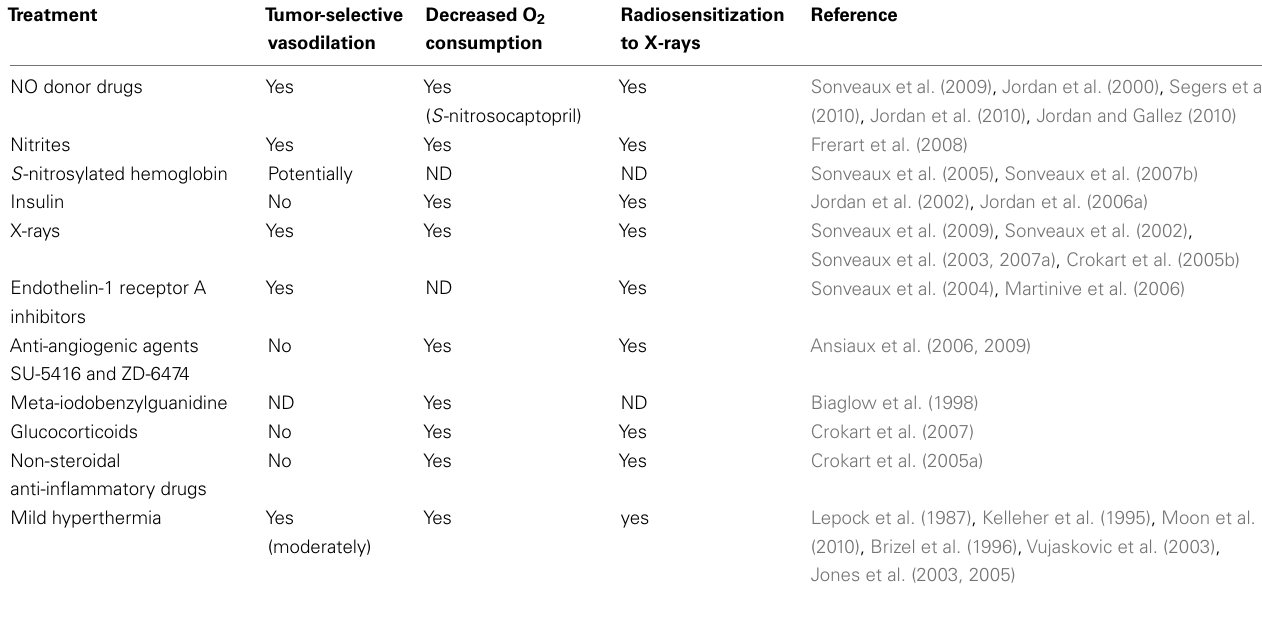
Table 1 | Pharmacological interventions able to radiosensitize tumors through selective vasodilation and/or decreased oxygen consumption by tumor